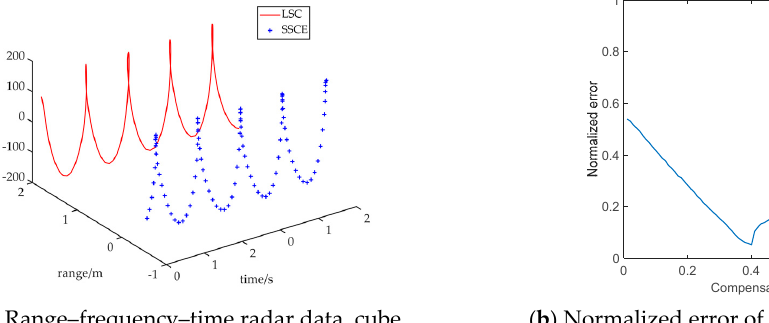
Figure 8. Parameter estimation method under case 2.